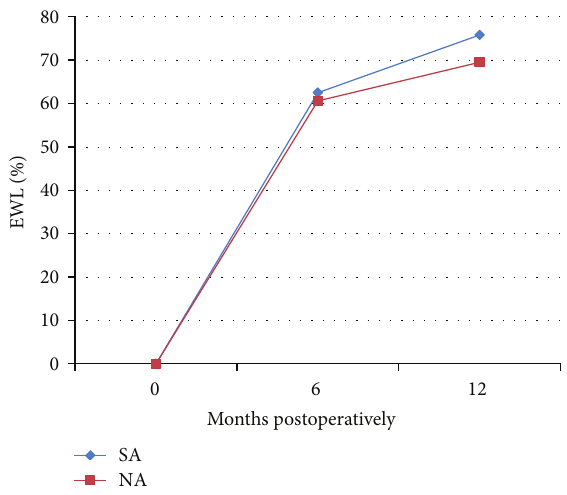
Figure 3: Percent excess weight loss (%EWL) in each group, after Roux-en-Y gastric bypass (RYGB). SA: substance abuse cohort; NA: no substance abuse cohort.